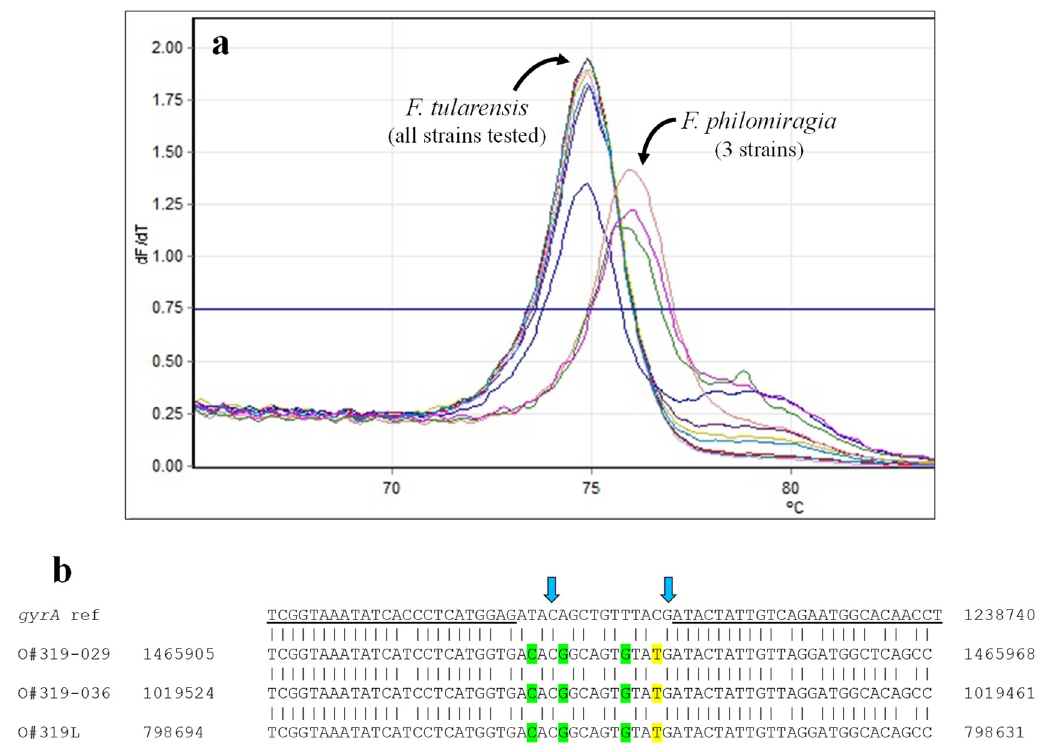
Figure 4. HRMA— Francisella spp. gyrA . ( a ) Melt curves for Francisella spp. gyrA amplicons. ( b ) Comparison of reference gyrA sequence with published sequences from F. philomiragia strains (see Table 8). All F. tularensis strains tested are identical to the reference sequence within the stretch interrogated. Primer sequences are underlined. Arrows indicate nucleotide positions where changes are demonstrated to result in quinolone resistance [34,35]. Sequence differences predicted to result in increased or decreased T m s are highlighted in green and yellow, respectively. Table 4. High resolution melt analysis (HRMA) melt temperatures and clusters for Francisella spp. strains.